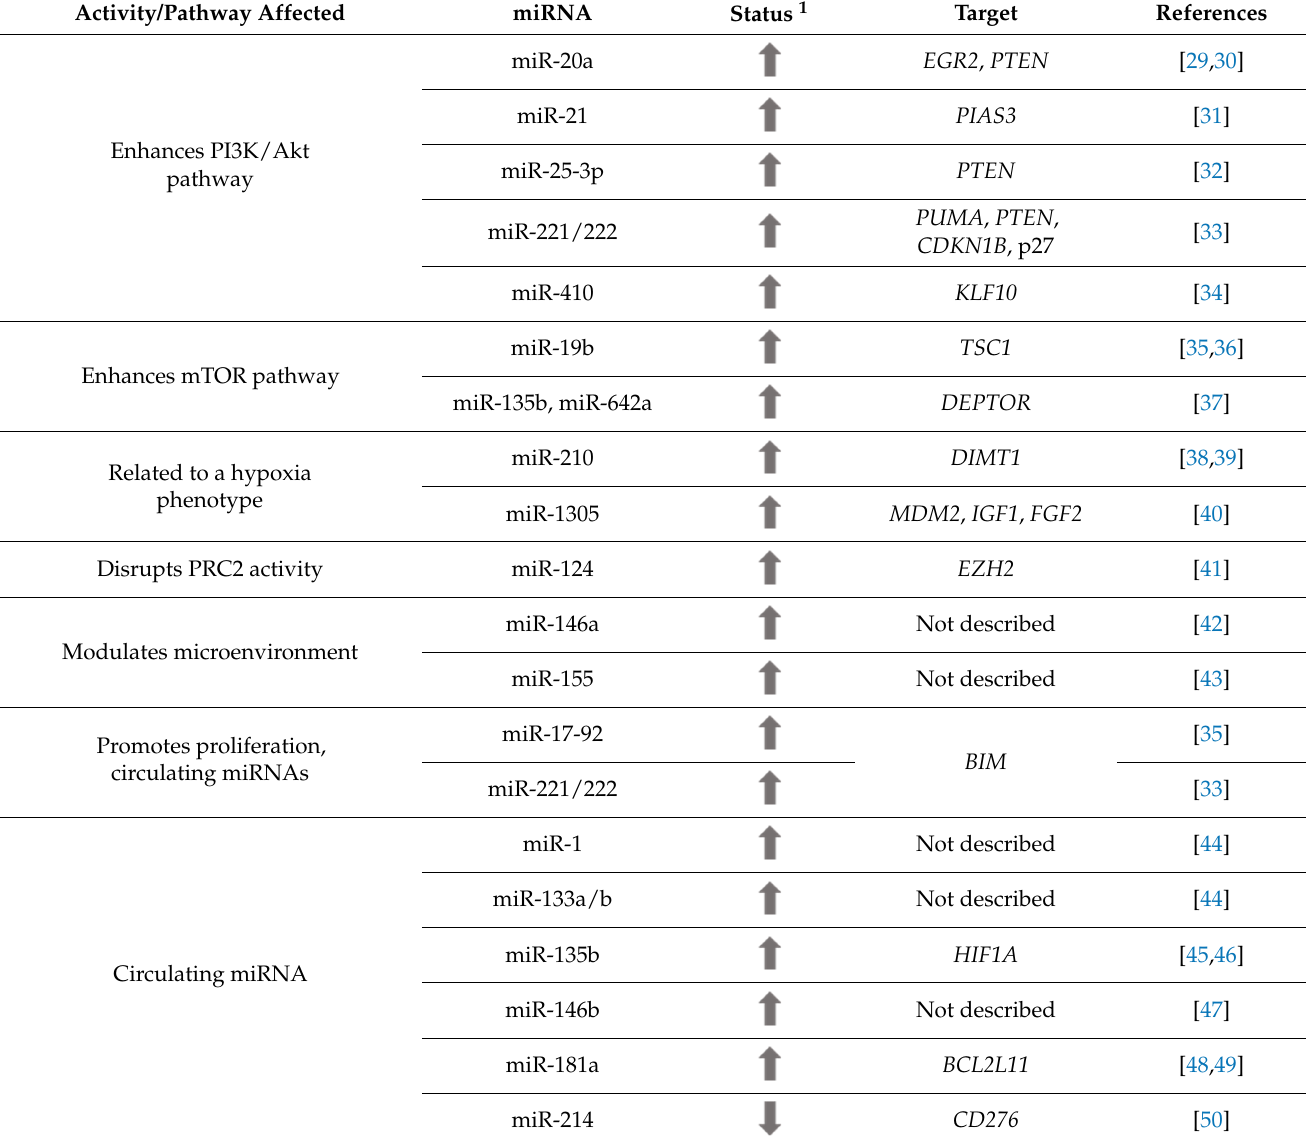
Figure 2. lncRNA classification attending to their localization. The enhancer, intronic, and intergenic lncRNAs contain their own promoters that are distinct from protein coding gene. Bidirectional lncRNAs share promoter with a protein coding gene and are transcribed from the opposite strand of the gene. Antisense (AS) lncRNAs have been involved in the transcriptional interference of the neighboring protein coding genes.